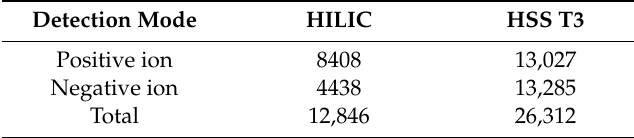
Table 1. The number of features.